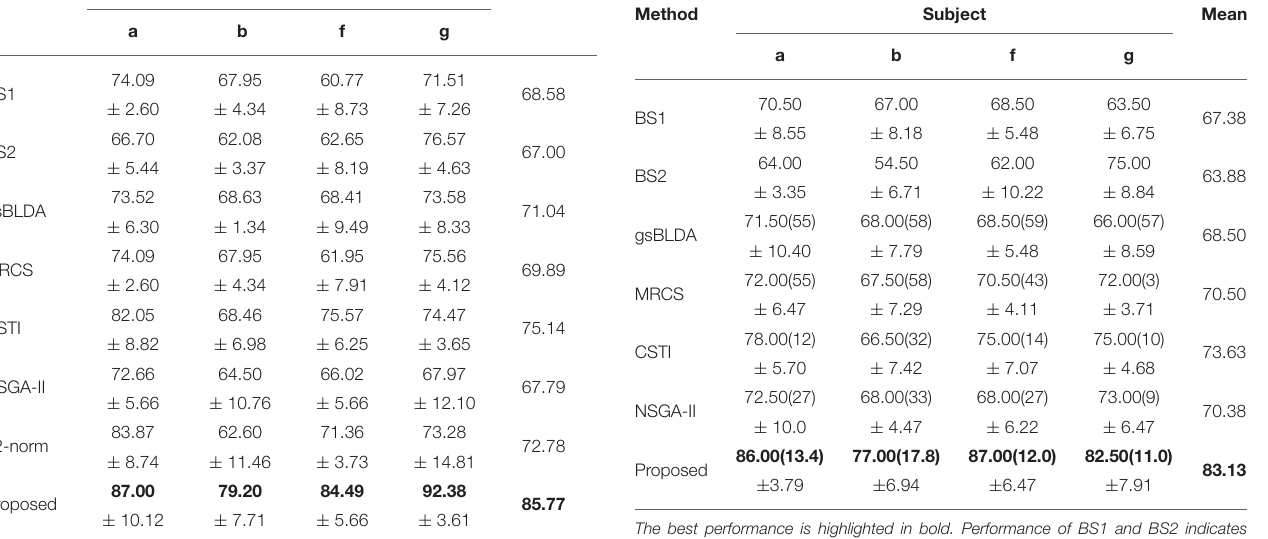
TABLE 6 | The mean F1 score and standard deviation (%) of 5 cross-validation of COL and baselines on 4 subjects of DS2. Method